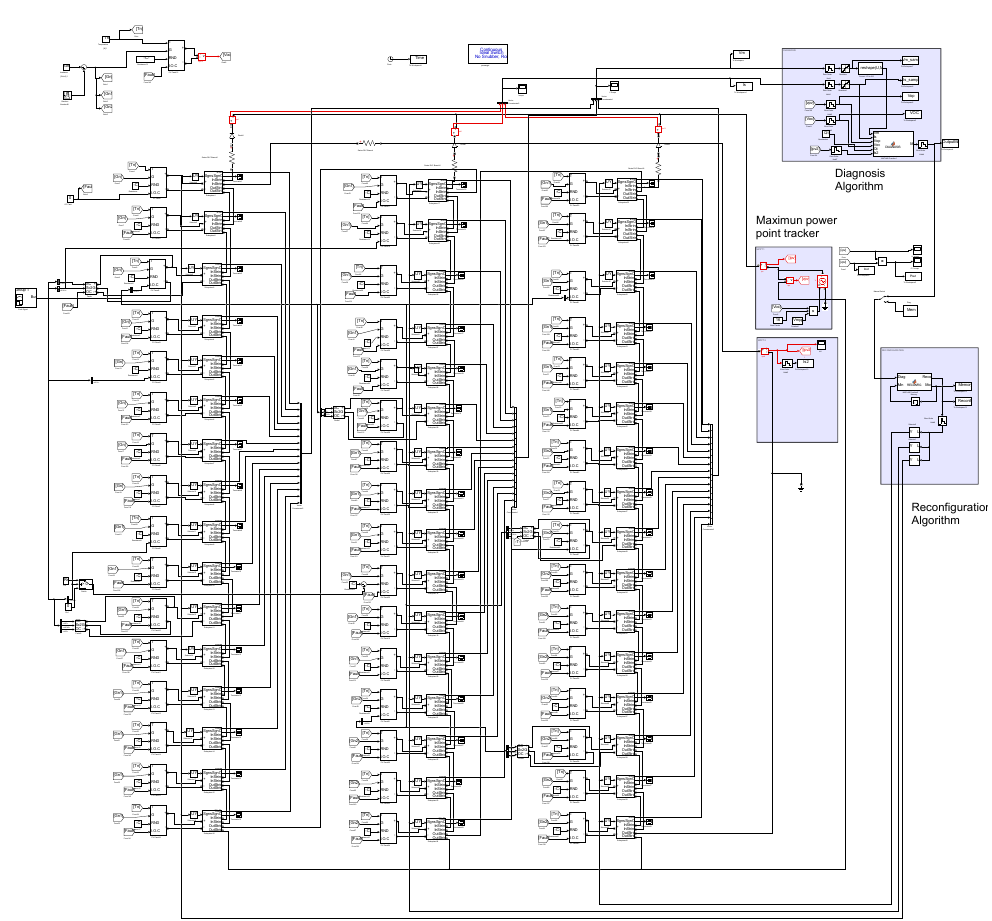
Figure A1. Test bench for the numerical